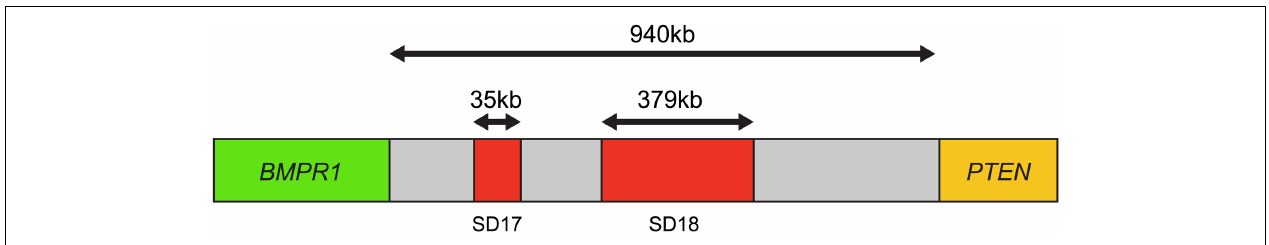
length, respectively. Both contain clusters of homologous inverted repeat sequences thought to cause genomic instability and mediate PTEN deletion. Based onYoshimoto et al.